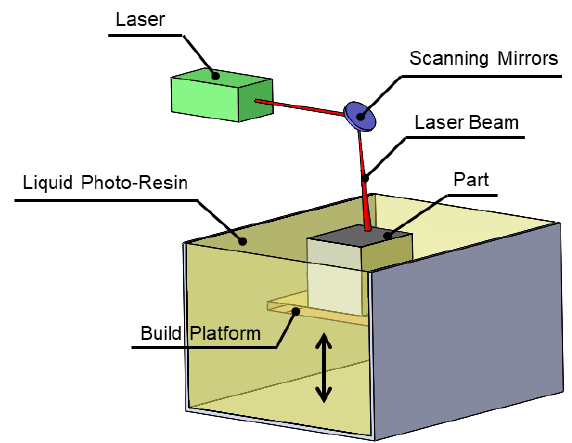
Figure 3. Schematic of stereolithography